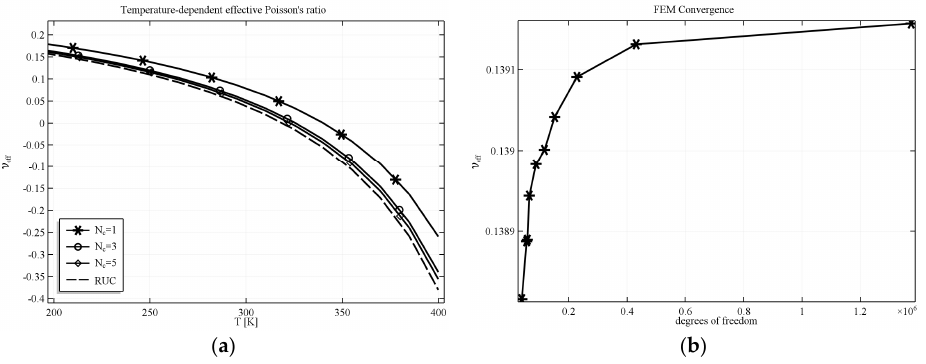
Figure 7. Effective Poisson’s ratio for AT geometry with filled voids in the case of computational filling material. ( a ) Convergence of the homogenized structure Nc —number of simulated unit cells in one quarter of the composite sample, RUC—repeating unit cell with periodic boundary conditions; ( b ) Result of convergence analysis with respect to the number of degrees of freedom for selected value of T = 250 K.